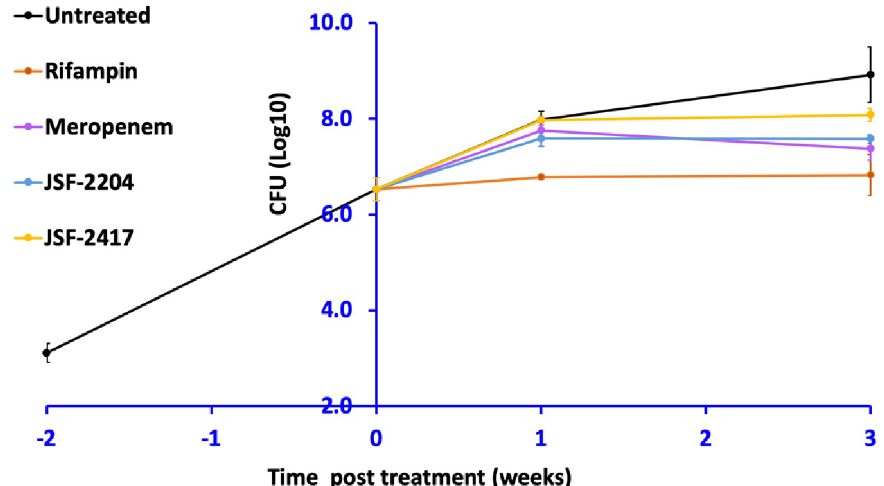
Fig 4. M . tuberculosis burden in the lungs of mice. Mean M . tuberculosis burdens in the lungs of five mice per group per time point, including standard deviation of the mean, are illustrated. Meropenem and experimental carbapenems JSF-2417 and JSF-2204 were administered sc at 400 mg/kg